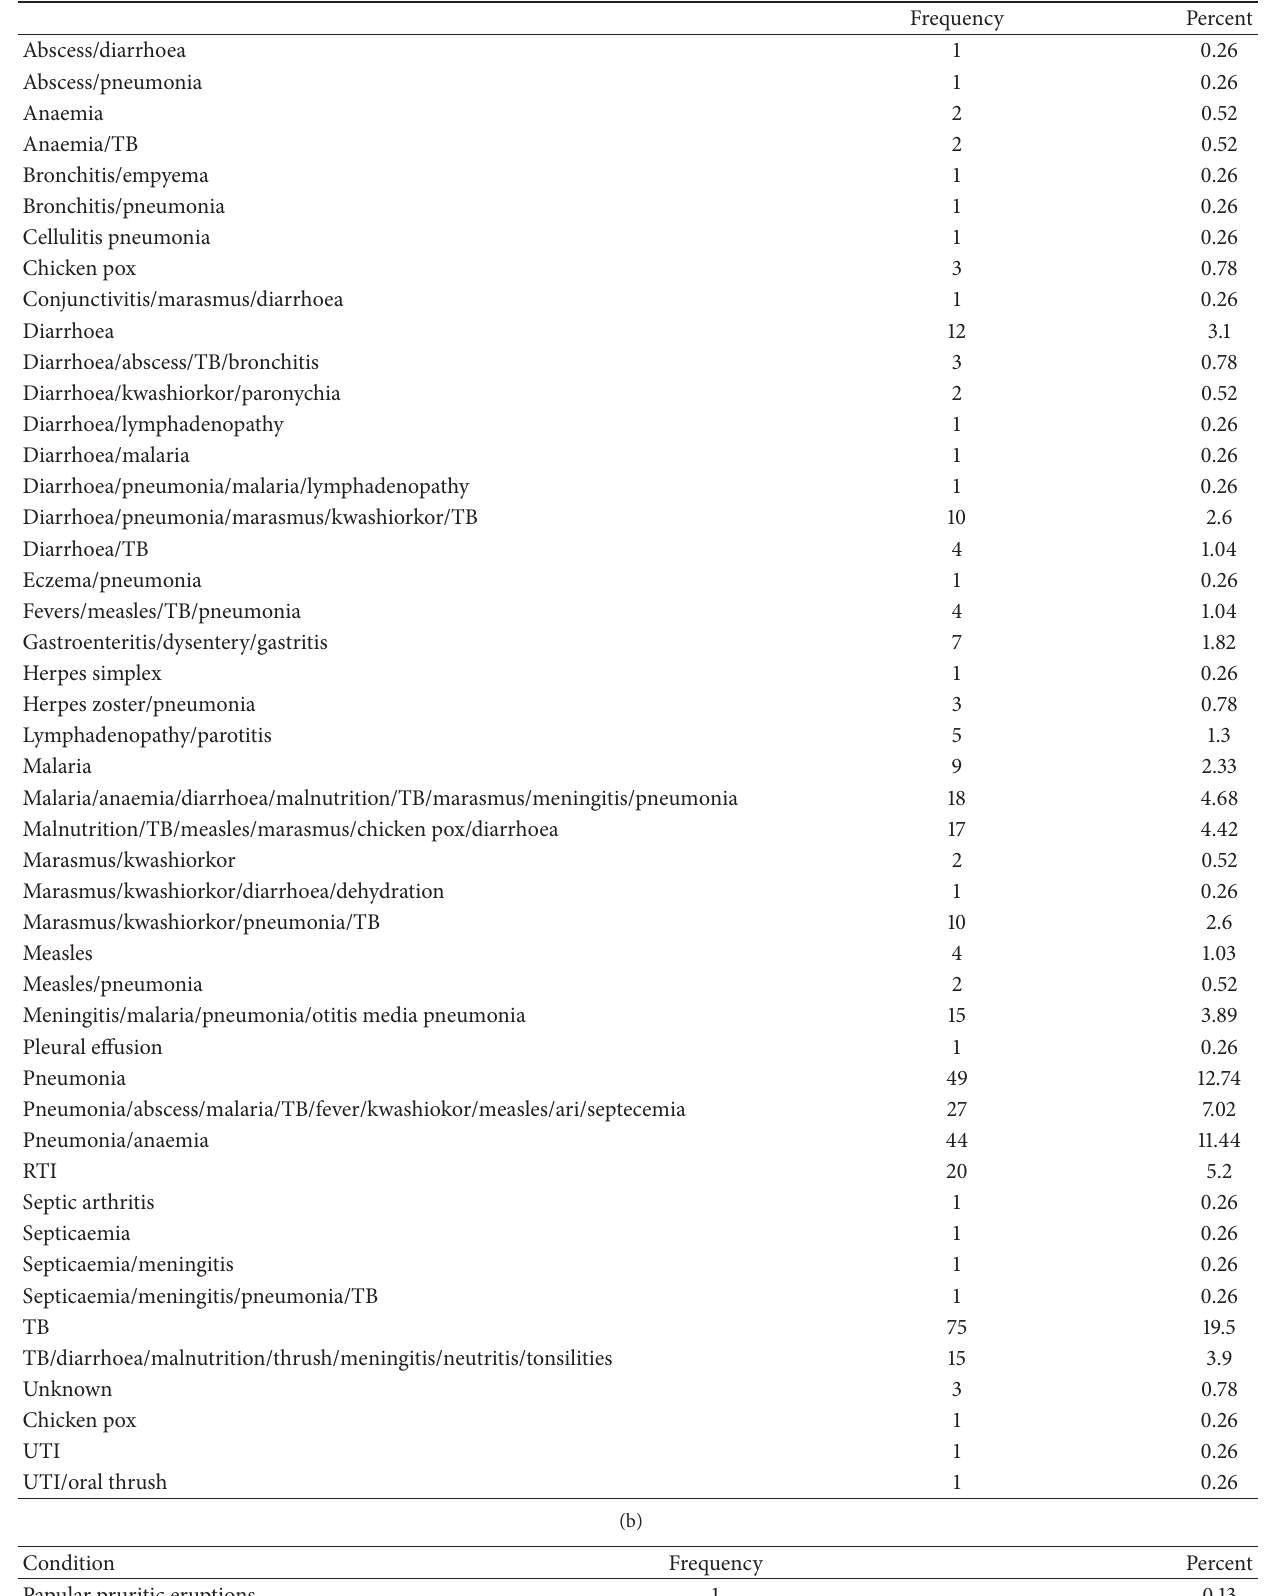
Table 5: (a) Causes of hospitalisation for children on cotrimoxazole. (b) Causes of hospitalisation for children on ARVs.